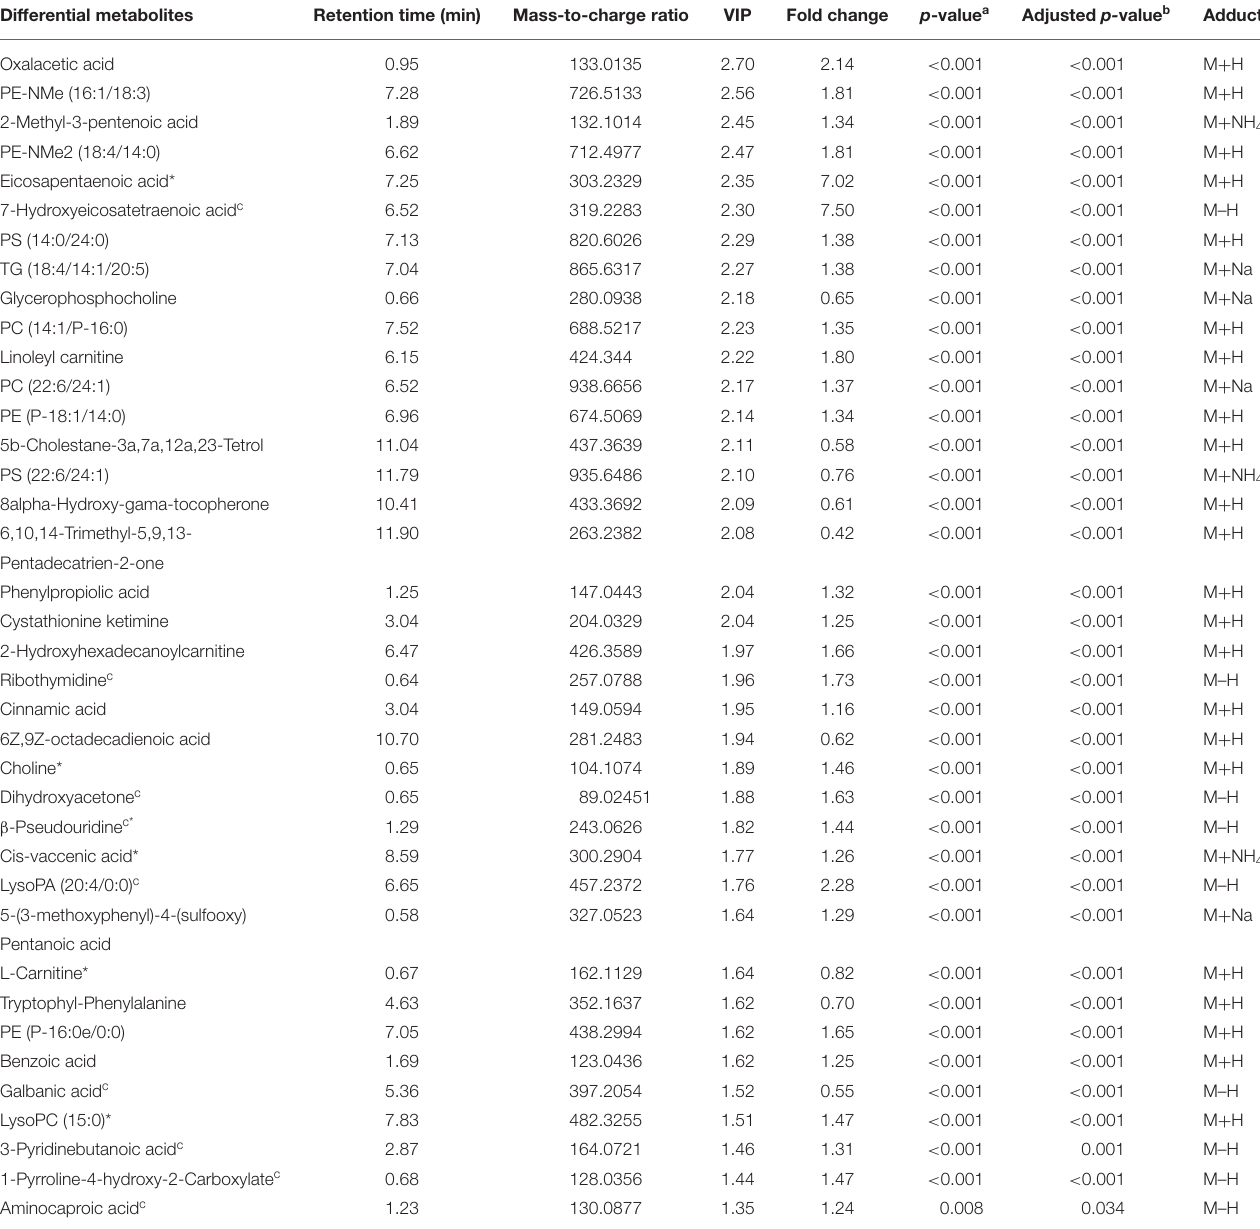
TABLE 2 | Statistical analysis of 38 differential metabolites in serum identified from the comparison of HSPN ( + ) vs. HSPN (–). Differential metabolites Retention time (min) Mass-to-charge ratio VIP Fold change p -value a Adjusted p- value b Adduct 0.95 133.0135